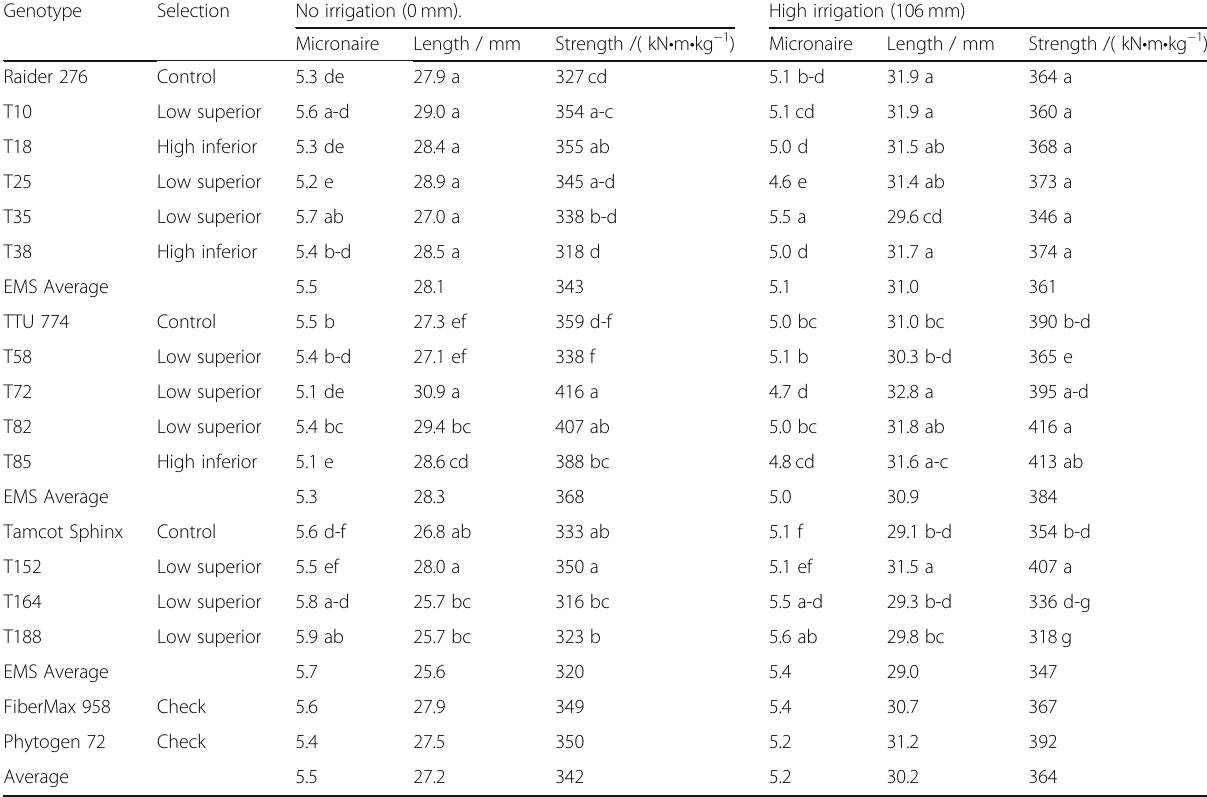
Table 6 Fiber quality of tetraploid selections at New Deal, TX (Location 2) in 2016 Genotype